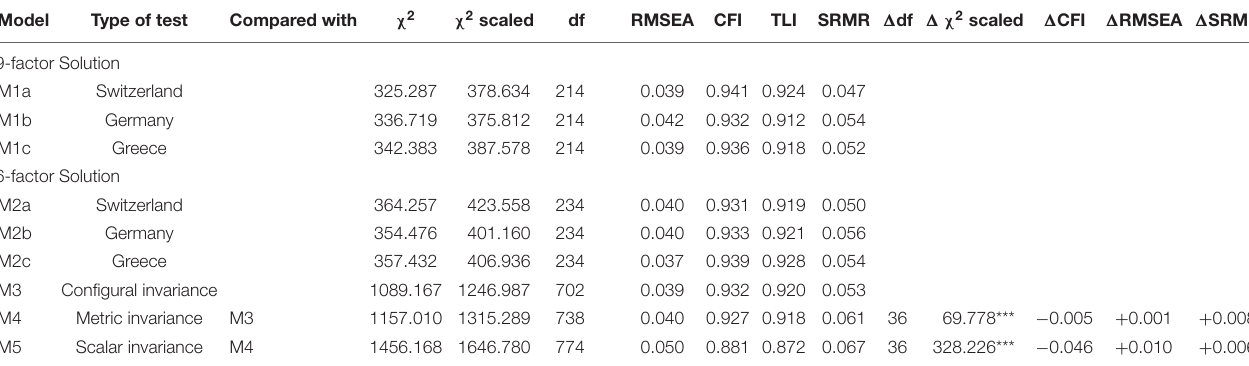
TABLE 4 | Evaluations of measurement invariance between Swiss, German, and Greek samples. Model